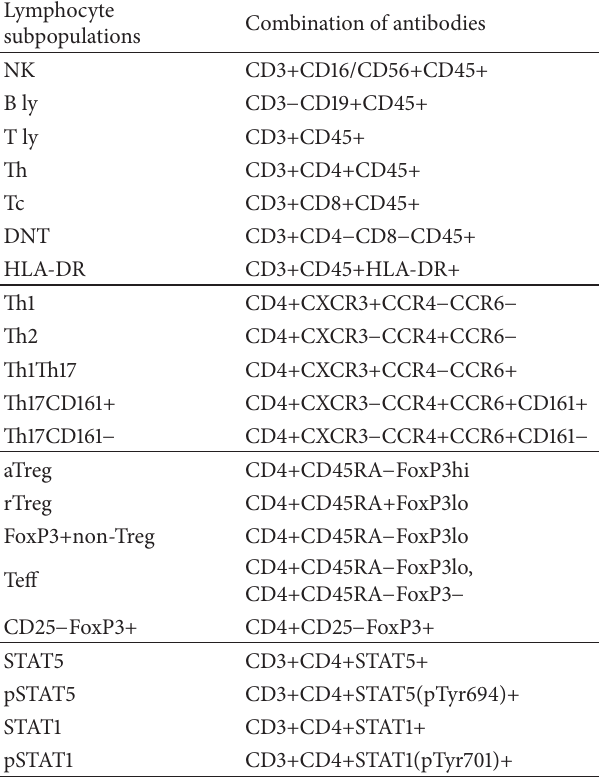
Table 1: Combination of antibodies used for identification and analysis of different lymphocyte